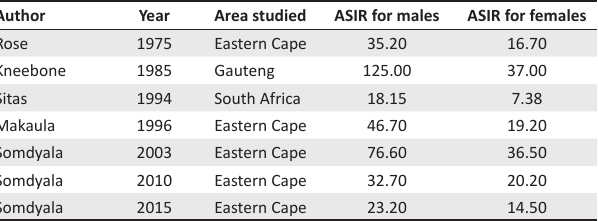
TABLE 1: Studies reporting on age-standardised incidence rate for oesophageal